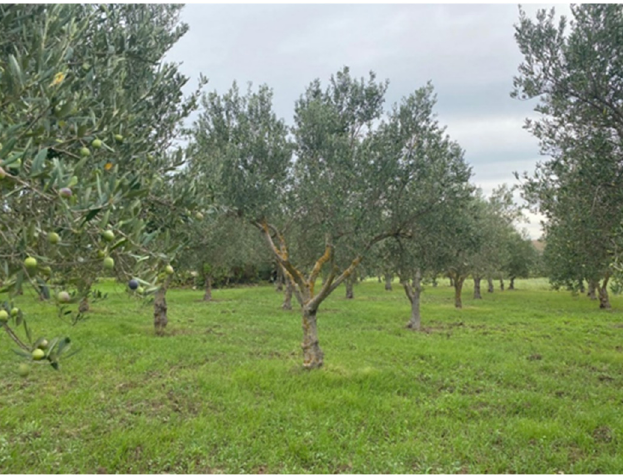
Figure 2. Experimental olive grove.